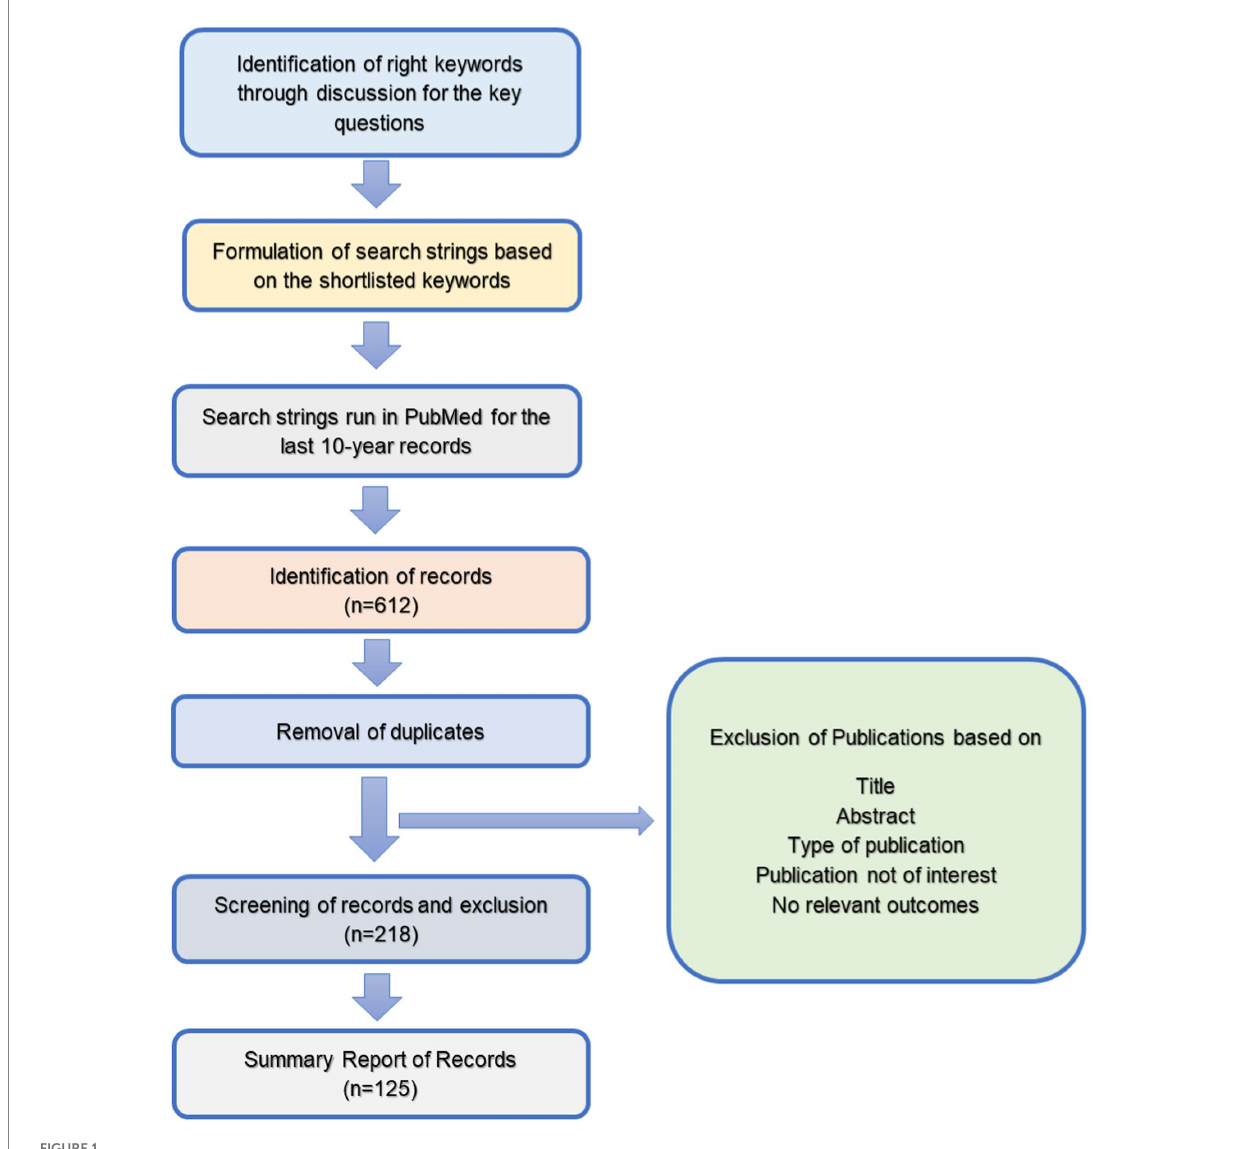
FIGURE 1 Flow diagram of the search strategy and study selection